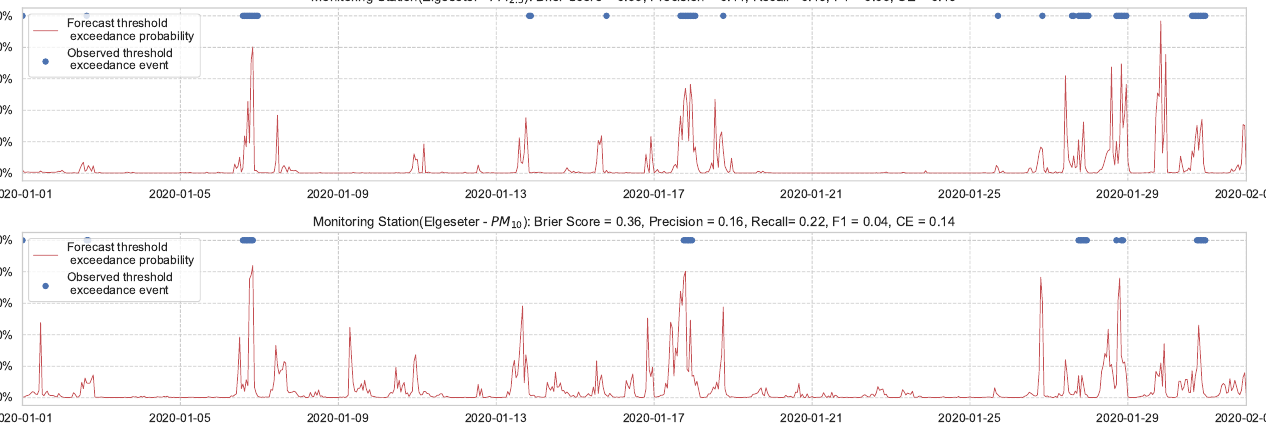
Figure 7. Predicting the threshold exceedance probability of the air pollutant level using an XGBoost model in one representative monitoring